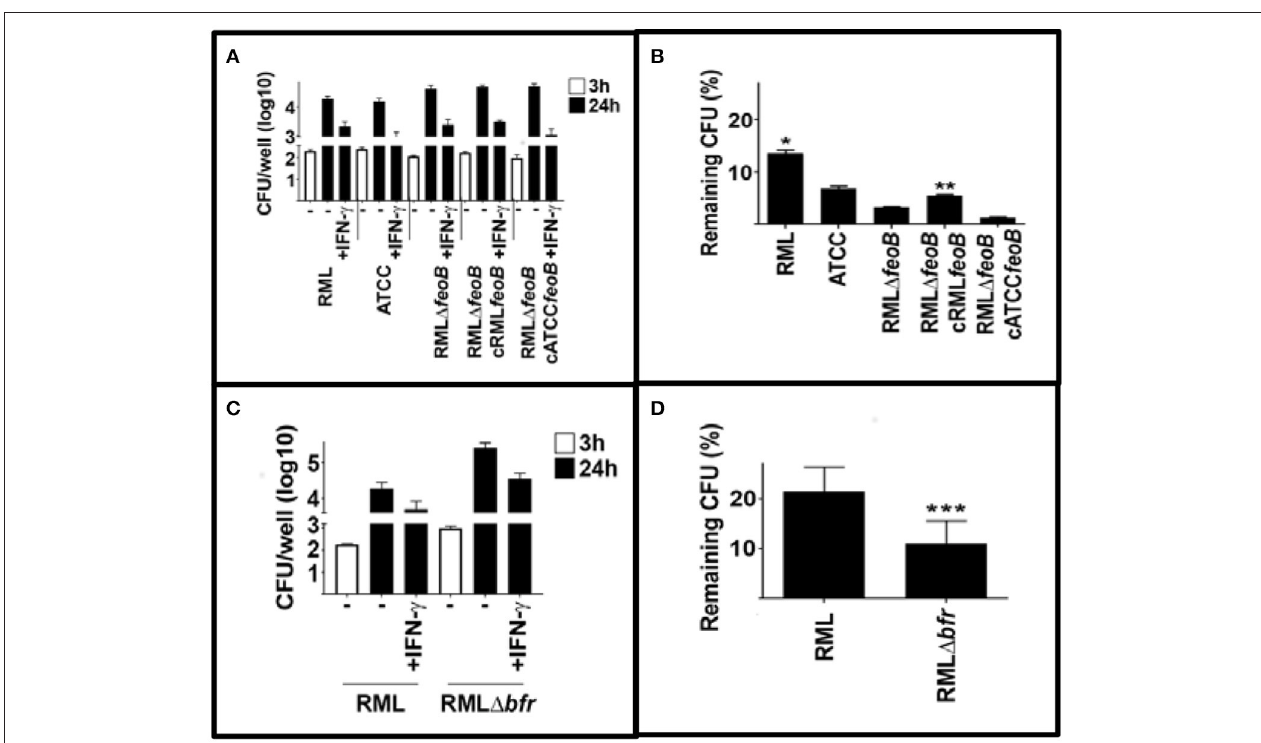
FIGURE 5 | Mutations in iron acquisition enhance sensitivity of LVS to IFN- γ mediated killing. BMM were infected with the indicated strains of LVS and were treated with IFN- γ (10 U/ml) immediately after infection. Three and 24h after infection intracellular bacteria were enumerated. (A,B) RML LVS is more resistant to IFN- γ mediated killing compared to all other strains tested. Deletion of the feoB gene rendered RML LVS more sensitive to IFN- γ mediated killing and complementation with homologous feoB , but not ATCC feoB partially restored resistance to IFN- γ . (C,D) Deletion of the bacterioferritin ( bfr ) also increased RML LVS sensitivity to IFN- γ mediated killing. Error bars represent SD. Significance was tested via two-way ANOVA followed by Tukey’s multiple comparison of means. Significance was set at p < 0.05. *, significantly greater than all other samples. **, significantly greater than RML 1 feoB . ***, significantly less than RML LVS. Data is representative of three experiments of similar